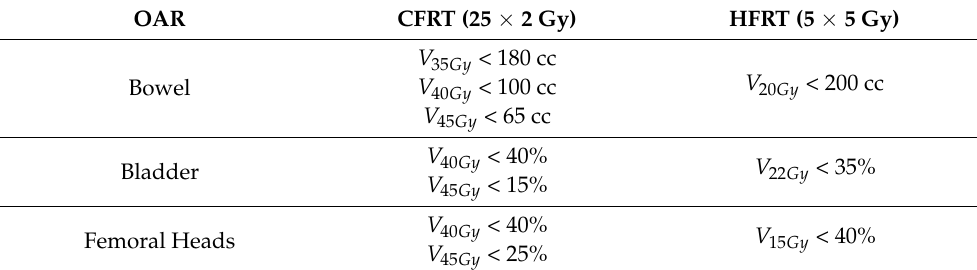
Abbreviations: CFRT: Conventionally Fractionated Radiation Therapy; HFRT: Hypo-Fractionated Radiation